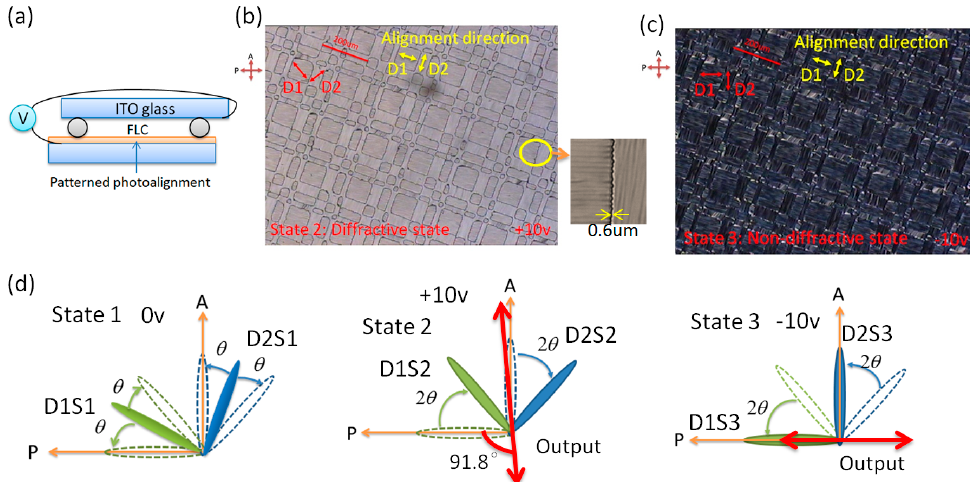
Figure 2. ( a ) Structure of the prepared FLC DG; ( b ) Microscopic photo of the ESH-FLC DG in the diffractive state under crossed polarizer and analyzer; ( c ) Microscopic photo of the ESH-FLC DG in the non-diffractive state under crossed polarizer and analyzer; ( d ) Illustration of the molecule orientation and output light polarization after the FLC cell in different states for the two domains.